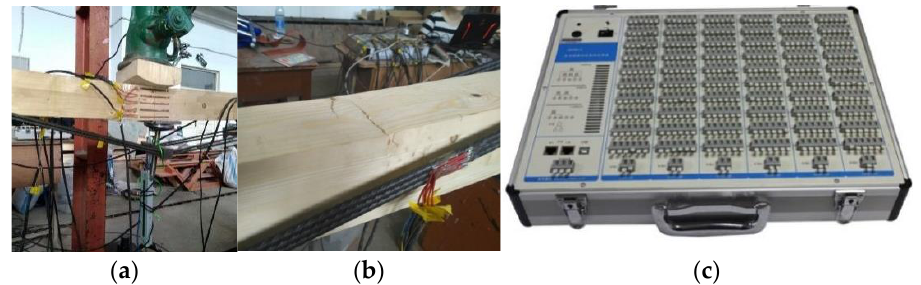
Figure 8. Strain Gauge Layout and Data Acquisition Device. ( a ) The strain gauge layout of glulam; ( b ) Layout diagram of steel strain gauge; ( c ) JM3813 Static Strain Testing and Analysis System.